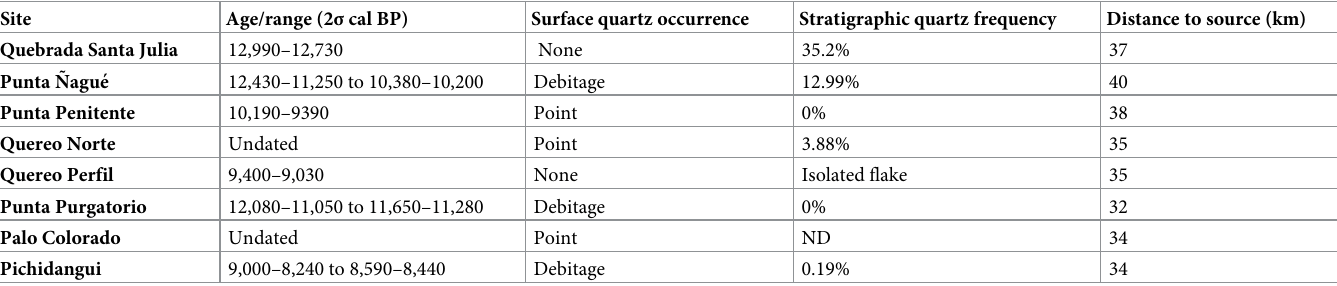
Table 6. Quartz occurrence and frequencies in local late Pleistocene to early Holocene